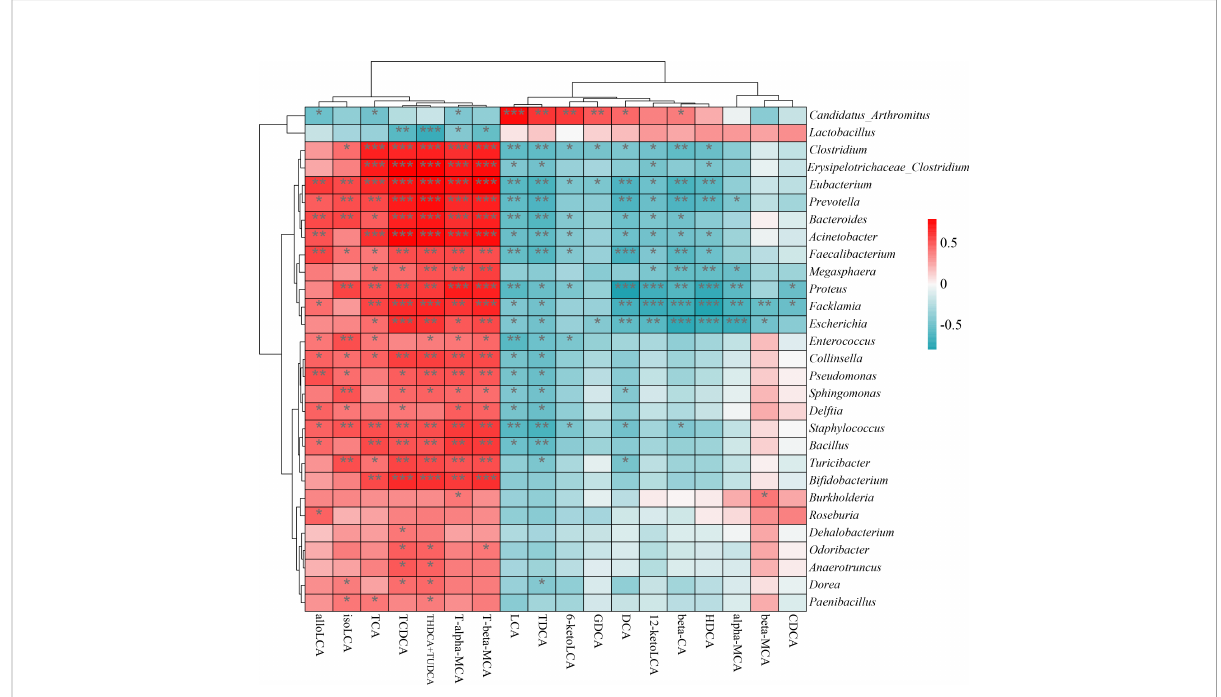
FIGURE 8 Correlation analysis investigating the association between gut microbiota and bile acids. Correlation coef fi cients are represented by the shades of color. Red and blue indicate positive and negative correlation, respectively. * P < 0.05, ** P < 0.01, and *** P <